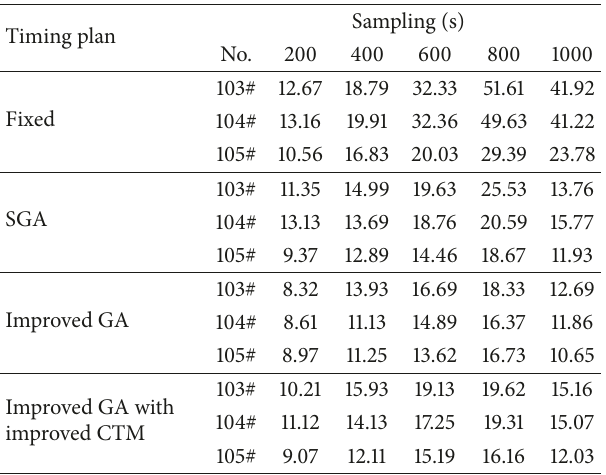
Table 4: Comparison table of the average delay